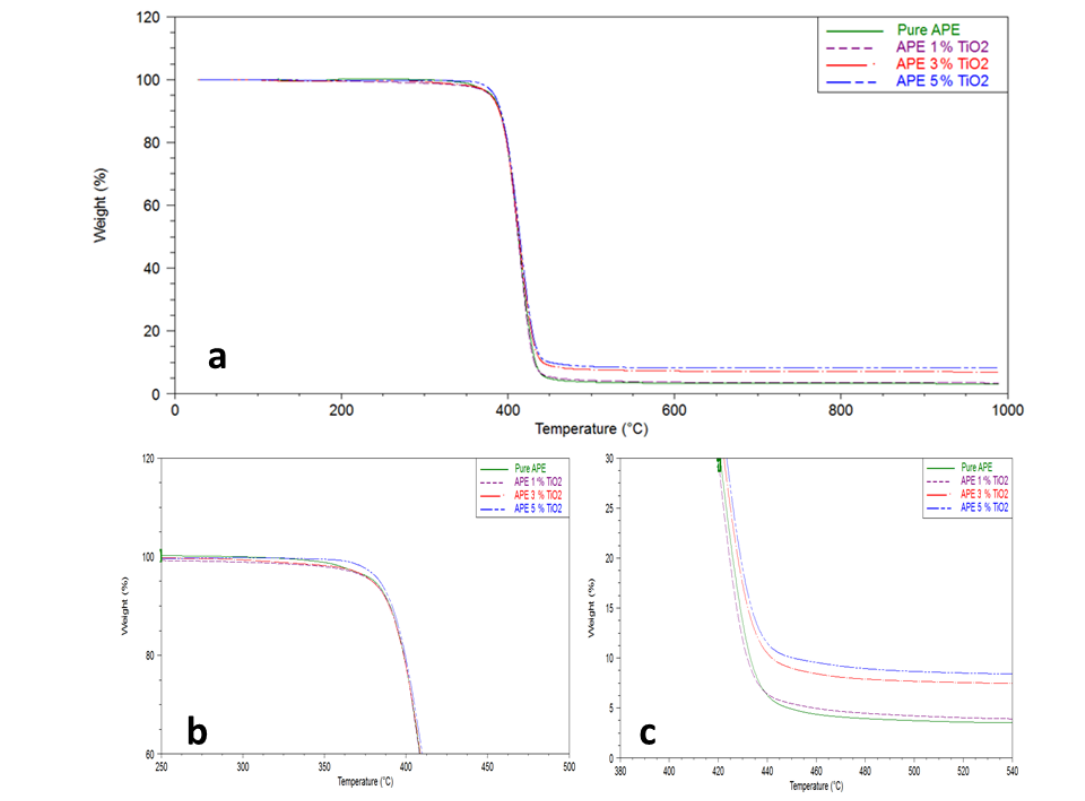
Fig. 4. Thermogravimetric analysis of the pure APE, APE with 1, 3 and 5% TiO region of degradation of APEs (c).